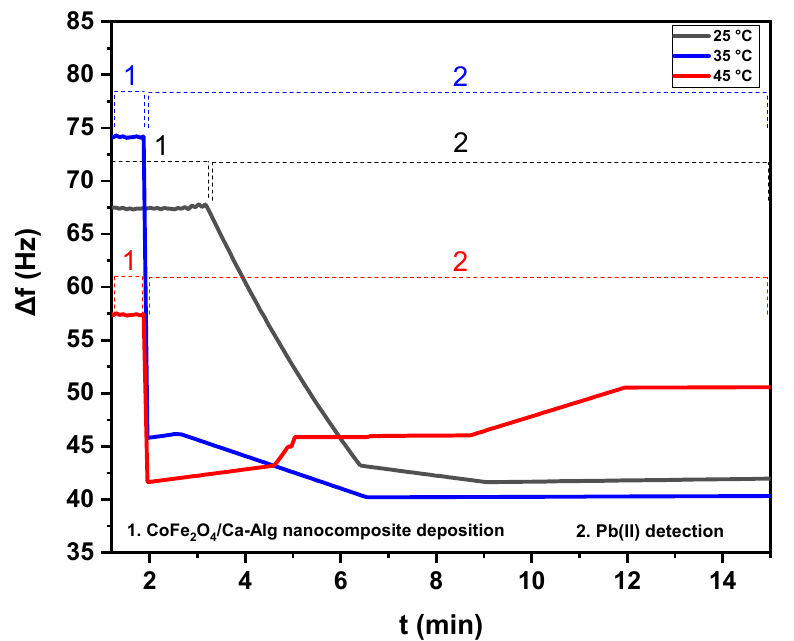
Figure 7. The net frequency shifts of the CoFe 2 O 4 /Ca-Alg nanocomposite-coated QCM nanosensors in Pb(II) aqueous solutions with different temperatures (25 °C, 35 °C, and 45 °C) as a function of time.